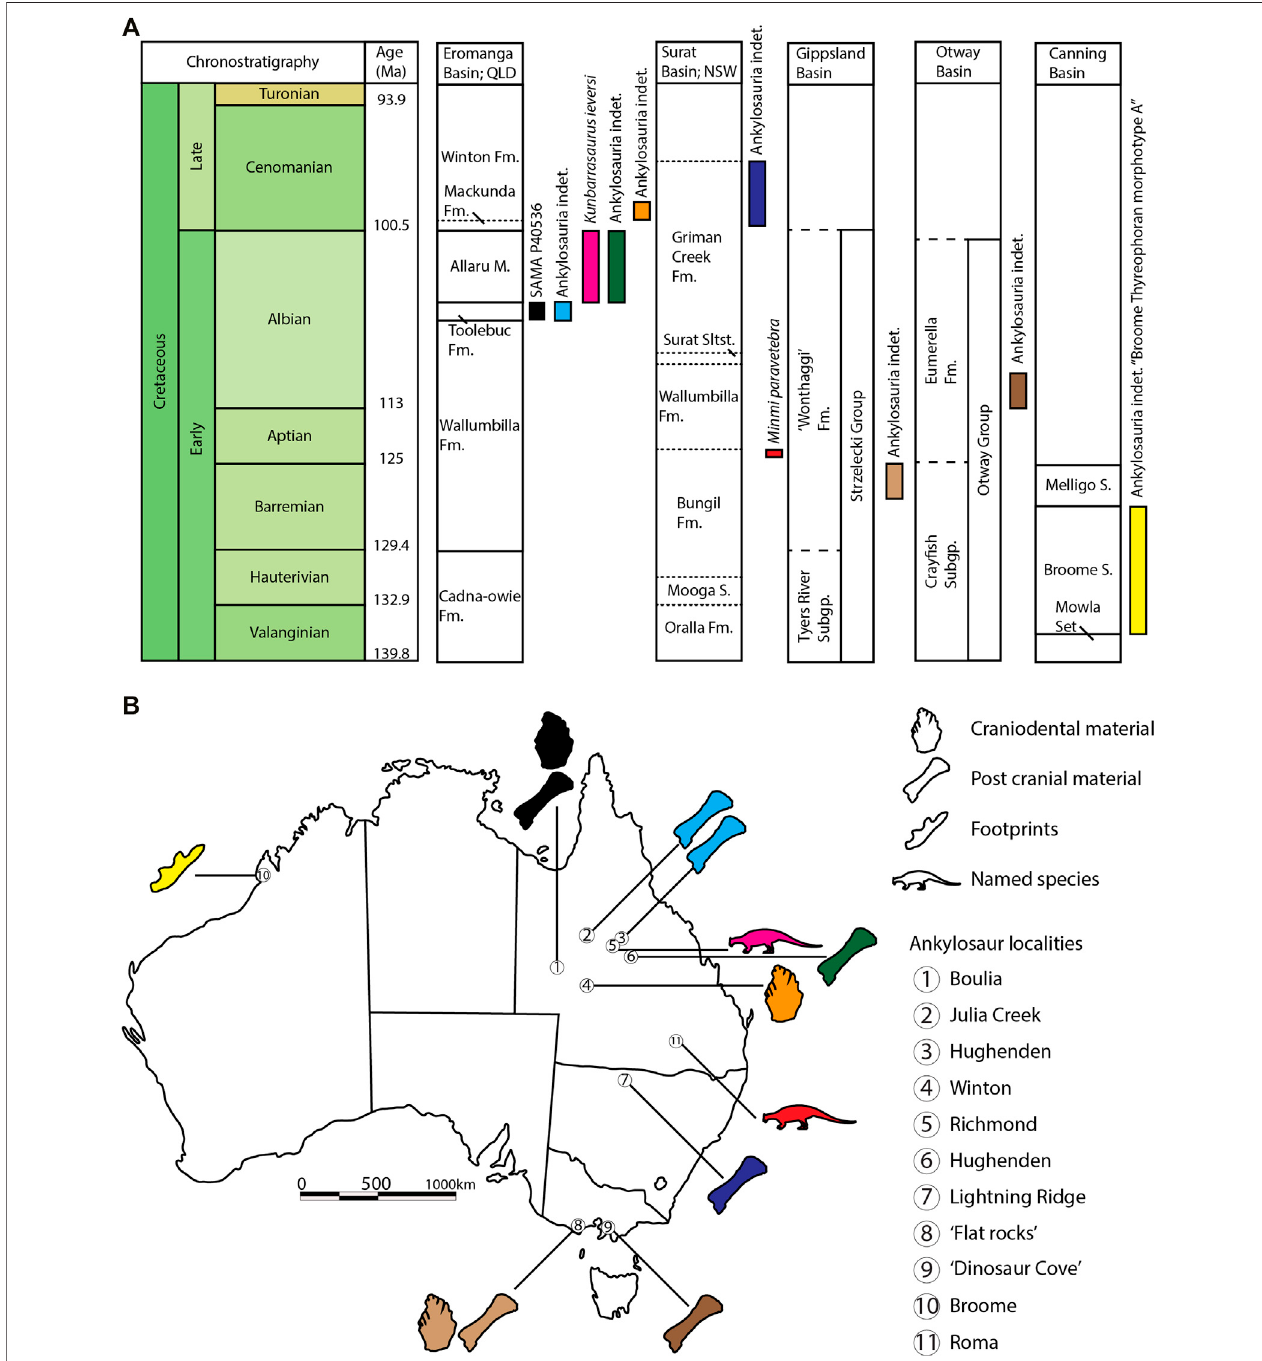
FIGURE9| Biostratigraphicandpalaeobiogeographiccontextofmid-CretaceousAustralianankylosaurs. (A) SimplebiostratigraphyofankylosaursfromtheSurat Basin (Molnar, 1980; Bell et al., 2018a), Eromanga Basin (Molnar, 1996; Leahey and Salisbury, 2013; Leahey et al., 2015), Gippsland and Otway Basins (Barrett et al., 2010),andCanningBasin(Salisburyetal.,2016).ChronostratigraphydatawascompiledfromSalisburyetal.(2016);Belletal.(2019);Wagstaffetal.(2020);andCooling et al. (2021). Dashed lines represent geological unconformities, whilst dotted lines represent gradational boundaries (B) Palaeobiogeography and the fossil record of Australian ankylosaurs from 11 sites, modi fi ed from Leahey et al. (2015). Ankylosaur silhouette generated by Jagged Fang Designs and reused under